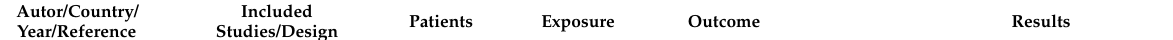
Table 1. Systematic reviews assessing the impact of time-to-treatment on survival from head and neck cancer. Autor/Country/